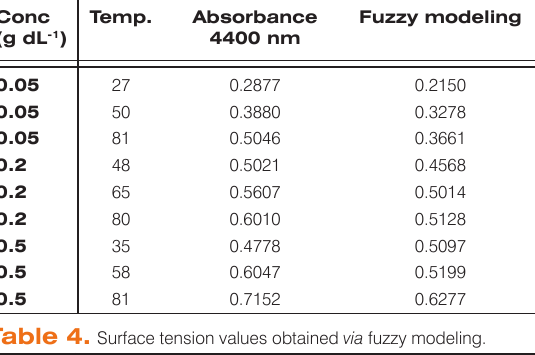
Table 4. Surface tension values obtained via fuzzy modeling. Conc Temp. Surface tension (g dL -1 ) (mM m -1